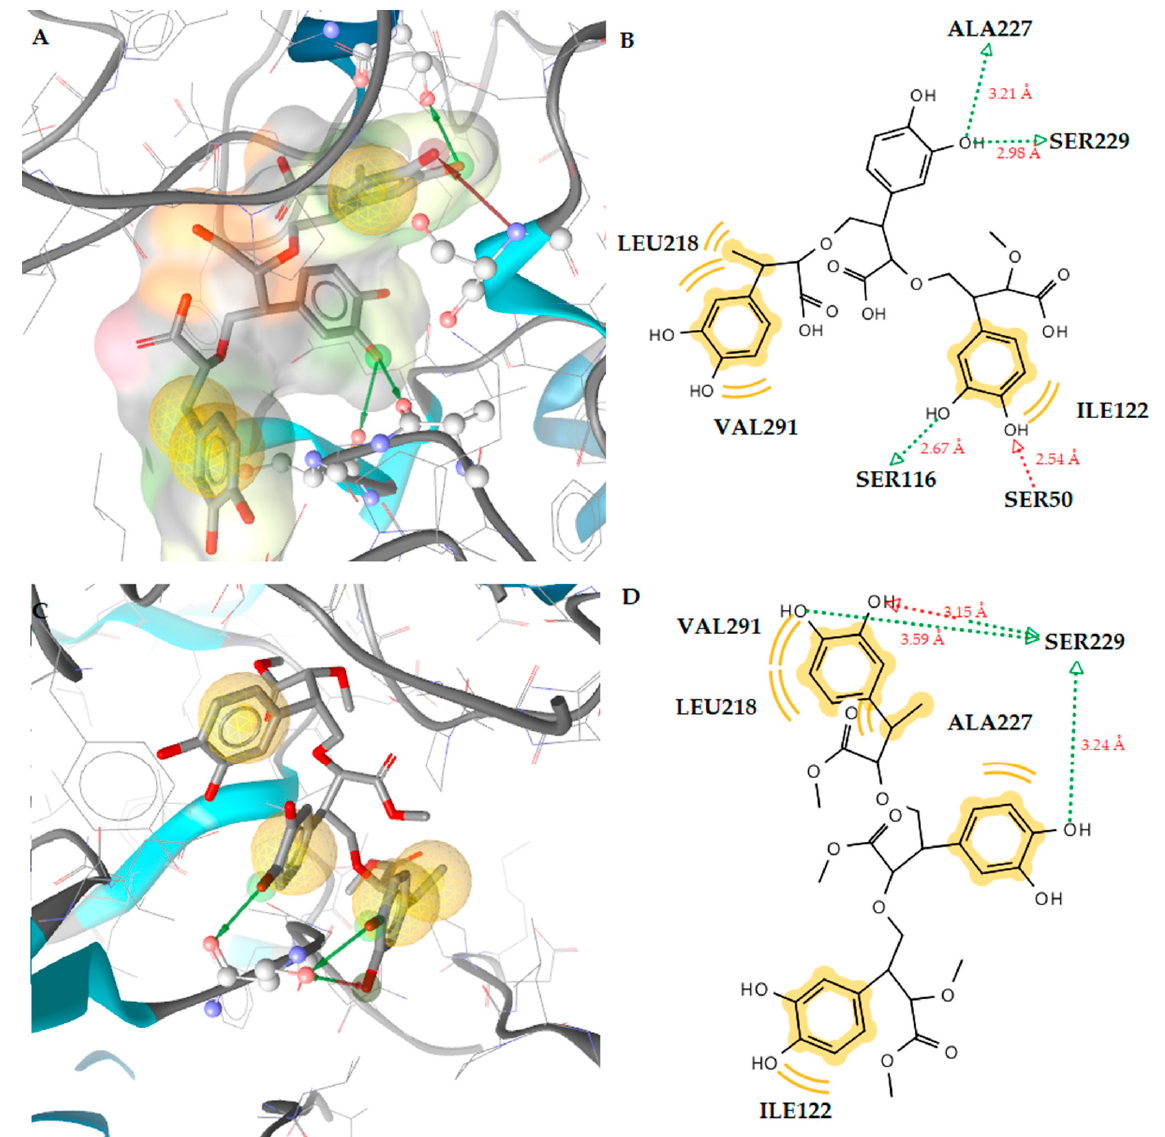
Figure 3. ( A ) A 2D diagram of dimer molecule 1 in E. coli MurB. ( B ) Docked pose of dimer molecule 1 in E. coli MurB. ( C ) A 2D diagram of dimer molecule 2 in E. coli MurB. ( D ) Docked pose of dimer molecule 2 in E. coli MurB. Red and green dotted lines show the hydrogen bonds. Yellow spheres represent hydrophobic interactions.